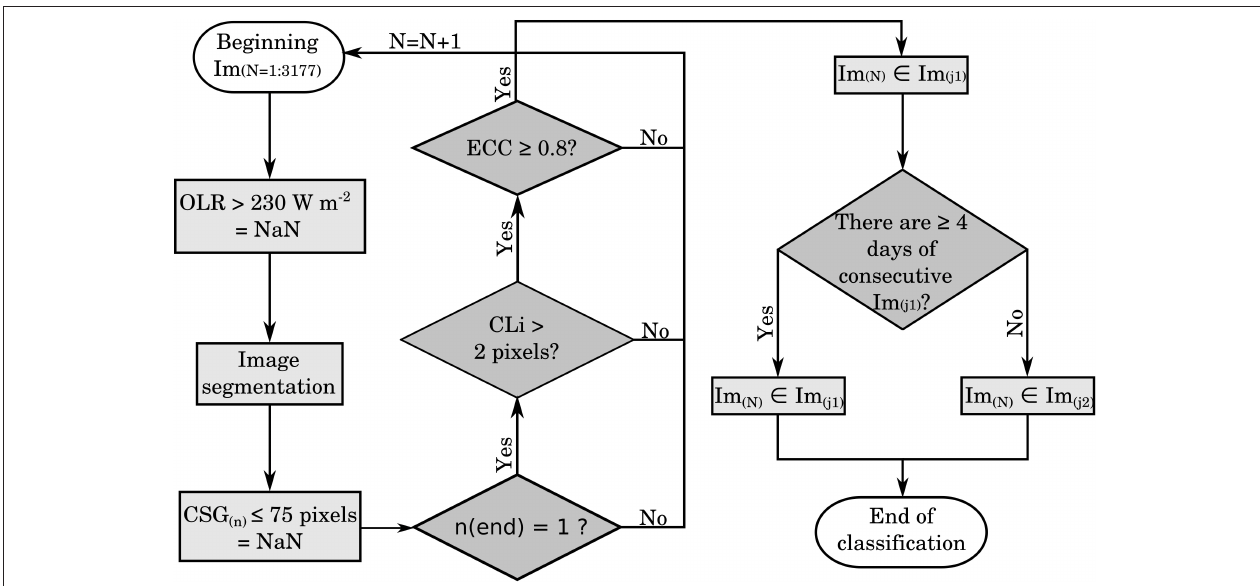
FIGURE 3 | Flow chart of the algorithm steps. Oval shapes represents starting and ending points of the algorithm. Boxes are individual steps and diamonds show the decision points (yes/no conditions). N is the time index (a total of 3,177 daily OLR images processed), CSG ( n ) is the convective segment candidate to SACZ, n is the index of the CSG ( n ) , CLi is the extension, given in pixels, in which the CSG ( n ) have to cross the coast line and ECC is the eccentricity required for the CSG ( n ) remains as a SACZ candidate. j1 (j2) represent the class of active (inactive) SACZ.